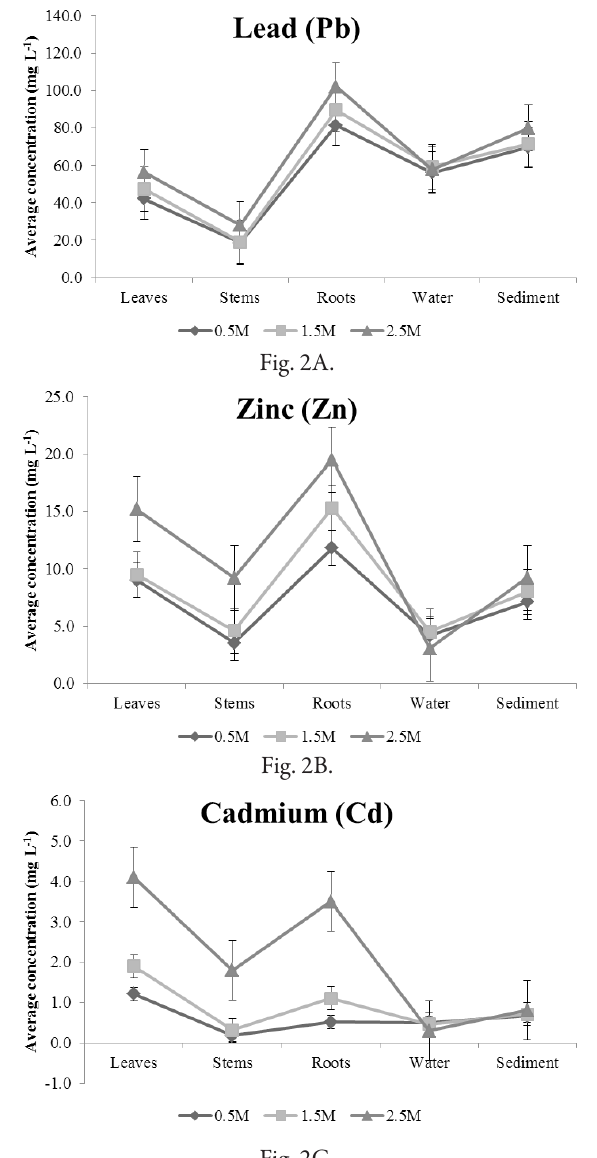
Fig. (2A-2C). The mean concentrations of Pb, Zn and Cd in the roots, stems, leaves, water and sediments of A. marina ( n=3 ) plantation of different height groups viz., 0.5 M, 1.5 M and 2.5